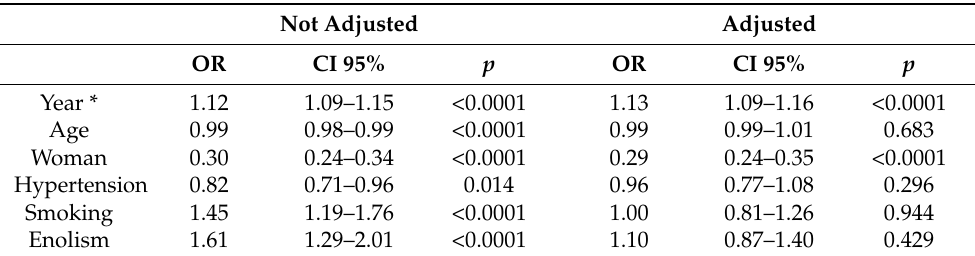
Table 1. Multivariate analysis of demographic aspects using latency times of 0–121 min (Q1) as dependent variable.